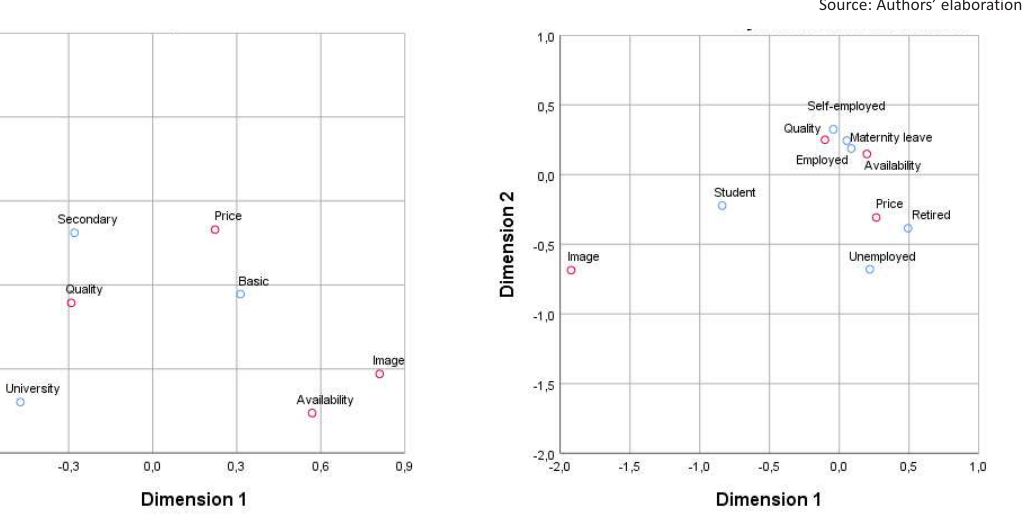
Figure 3. Correspondence map (Social